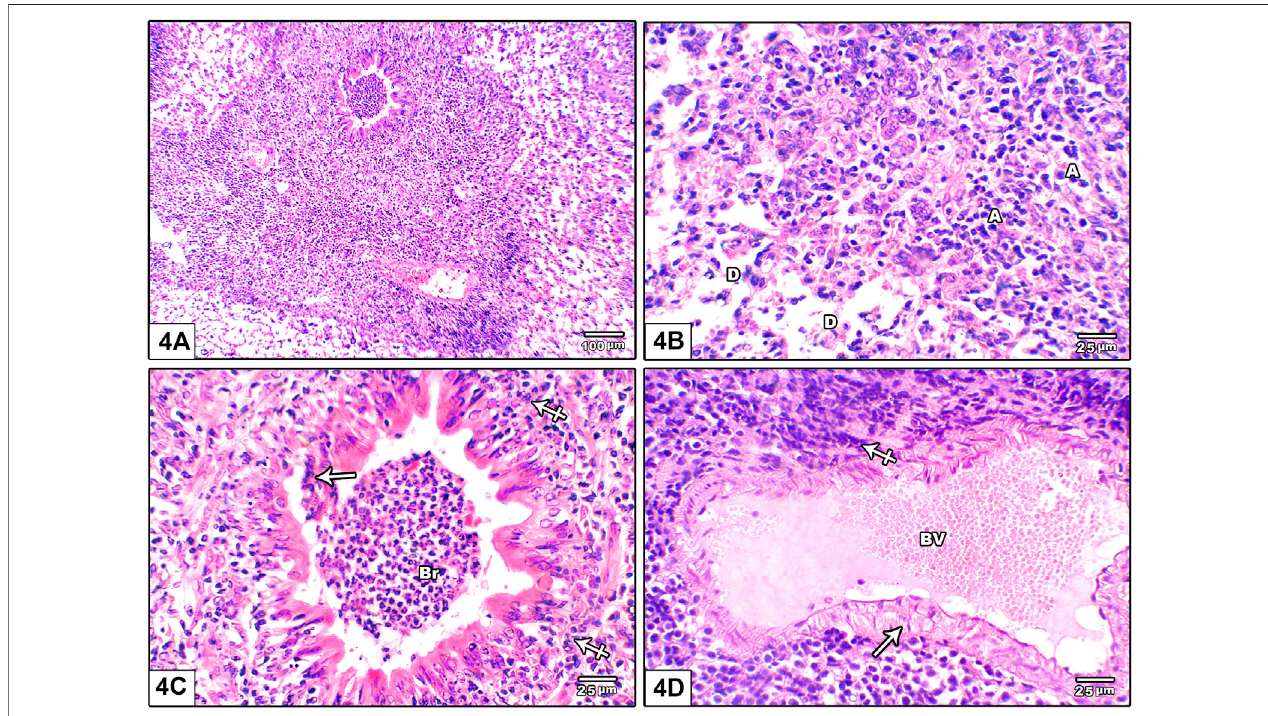
FIGURE 4 | Photomicrograph of H&E stained lung from le fl unomide 10 mg/kg group (A) An image shows markedly distorted lung architecture with heavy mononuclear in fl ammatory cell in fi ltrate (B) An image shows multiple areas of diffuse alveolar damage, thickened pulmonary interstitium with in fl ammatory cells and interstitial alveolar hemorrhage. Increased collapsed alveoli with thick wall (A) and few dilated ones with destroyed wall (D) (C) An image shows bronchioles (Br) lined by hyperplastic epithelium. The lumen containing cellular epithelial debris and in fl ammatory cells aggregate (crossed arrow) (D) An image shows markedly congested pulmonary blood vessels (BV) with marked perivascular cuf fi ng by mononuclear in fl ammatory cellular in fi ltrate, increased wall thickness (arrow).